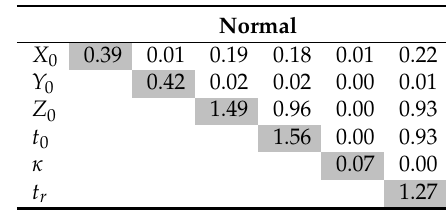
Table 4. Interpreted variance matrix Q ˆ computed from pseudorange observations of 8 satellites and P ˆ P image observations of 4 features, with integration model, units are [m, m, m, degree, m].